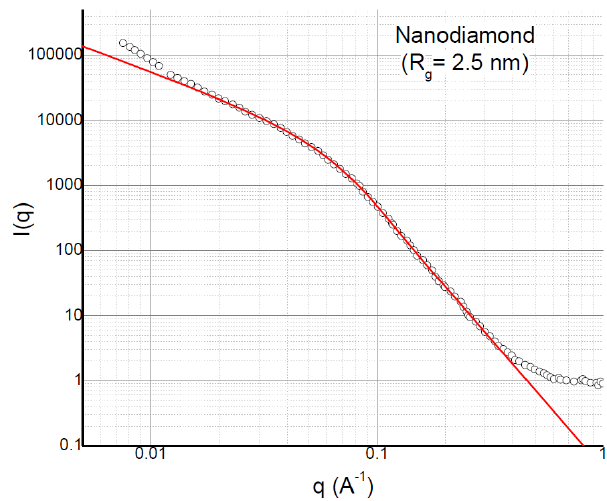
Fig. 3 : Small angle scattering intensity as experimentally determined by Teshigawara et al. [10] (open circles) and our fitted curve using the unified exponential/power-law approximation